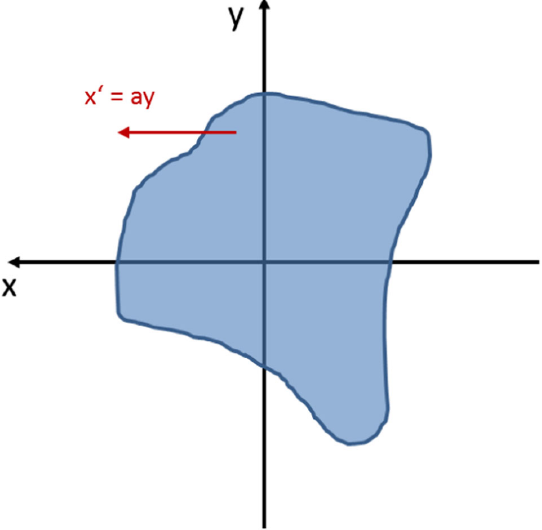
FIG. 4. Arbitrary area at a constant horizontal shear with strength a